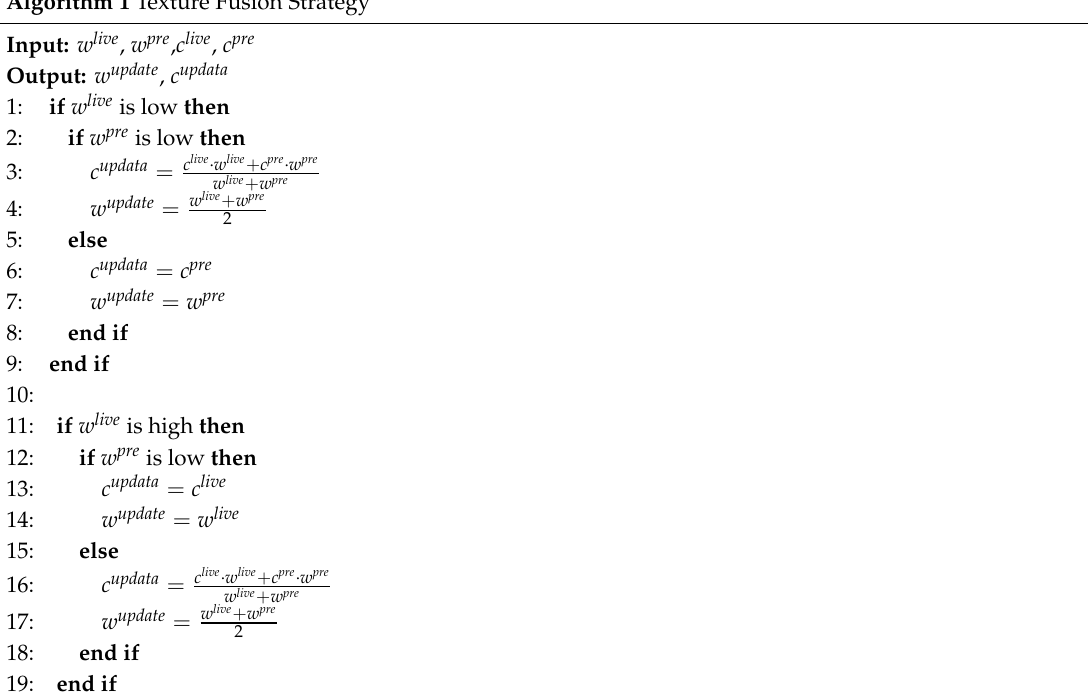
Algorithm 1 Texture Fusion